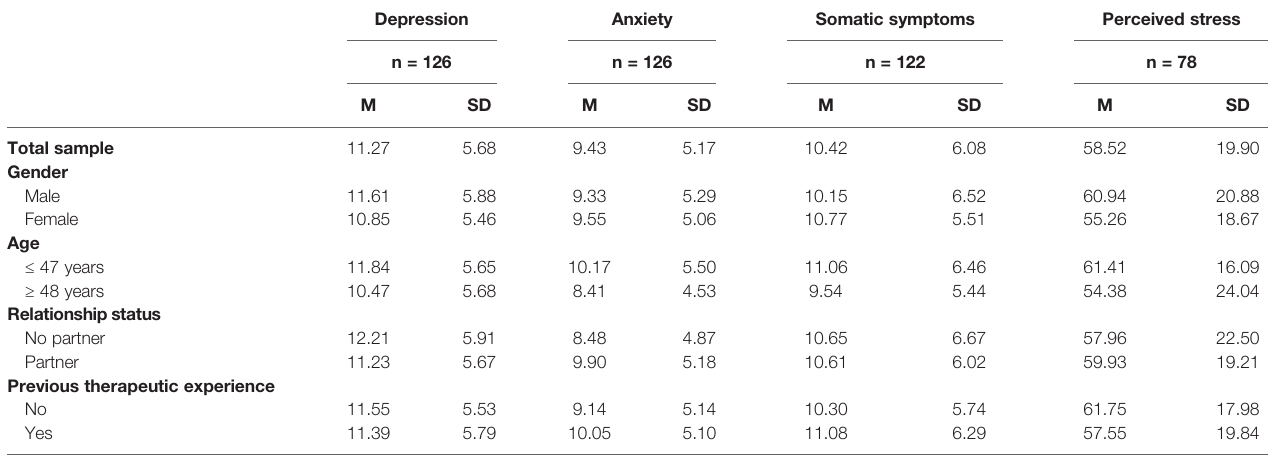
TABLE 2 | Means (M) and standard deviations (SDs) of depression (PHQ), anxiety (GAD), and somatic symptoms (PHQ) and perceived stress (PSQ) at baseline for the total sample and strati fi ed by gender, age groups, relationship status, and previous therapeutic experience. Depression Anxiety Somatic symptoms